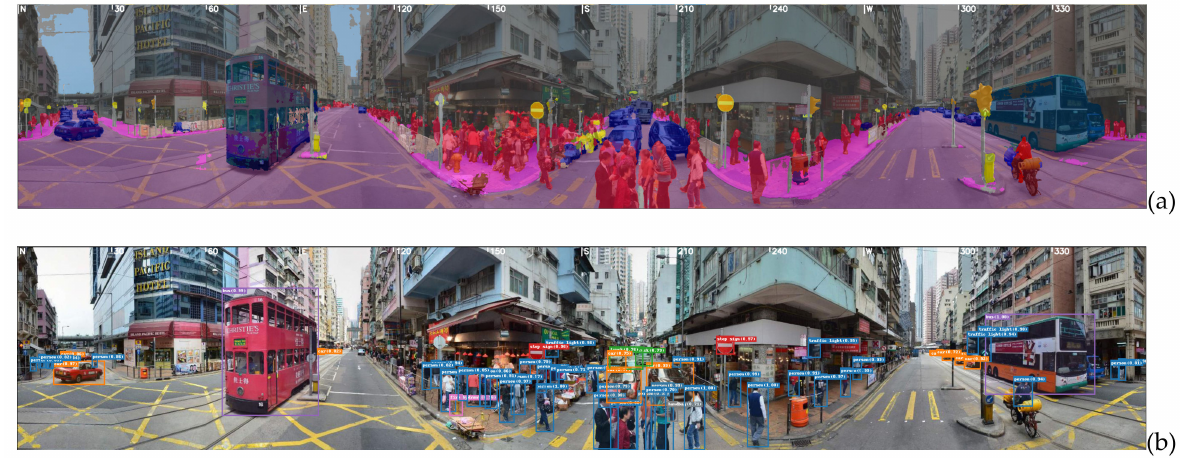
Figure 7. Results of semantic segmentation and object recognition. ( a ) Example of semantic segmentation, color indicates class; ( b ) example of object recognition, color of a bounding box indicates class.